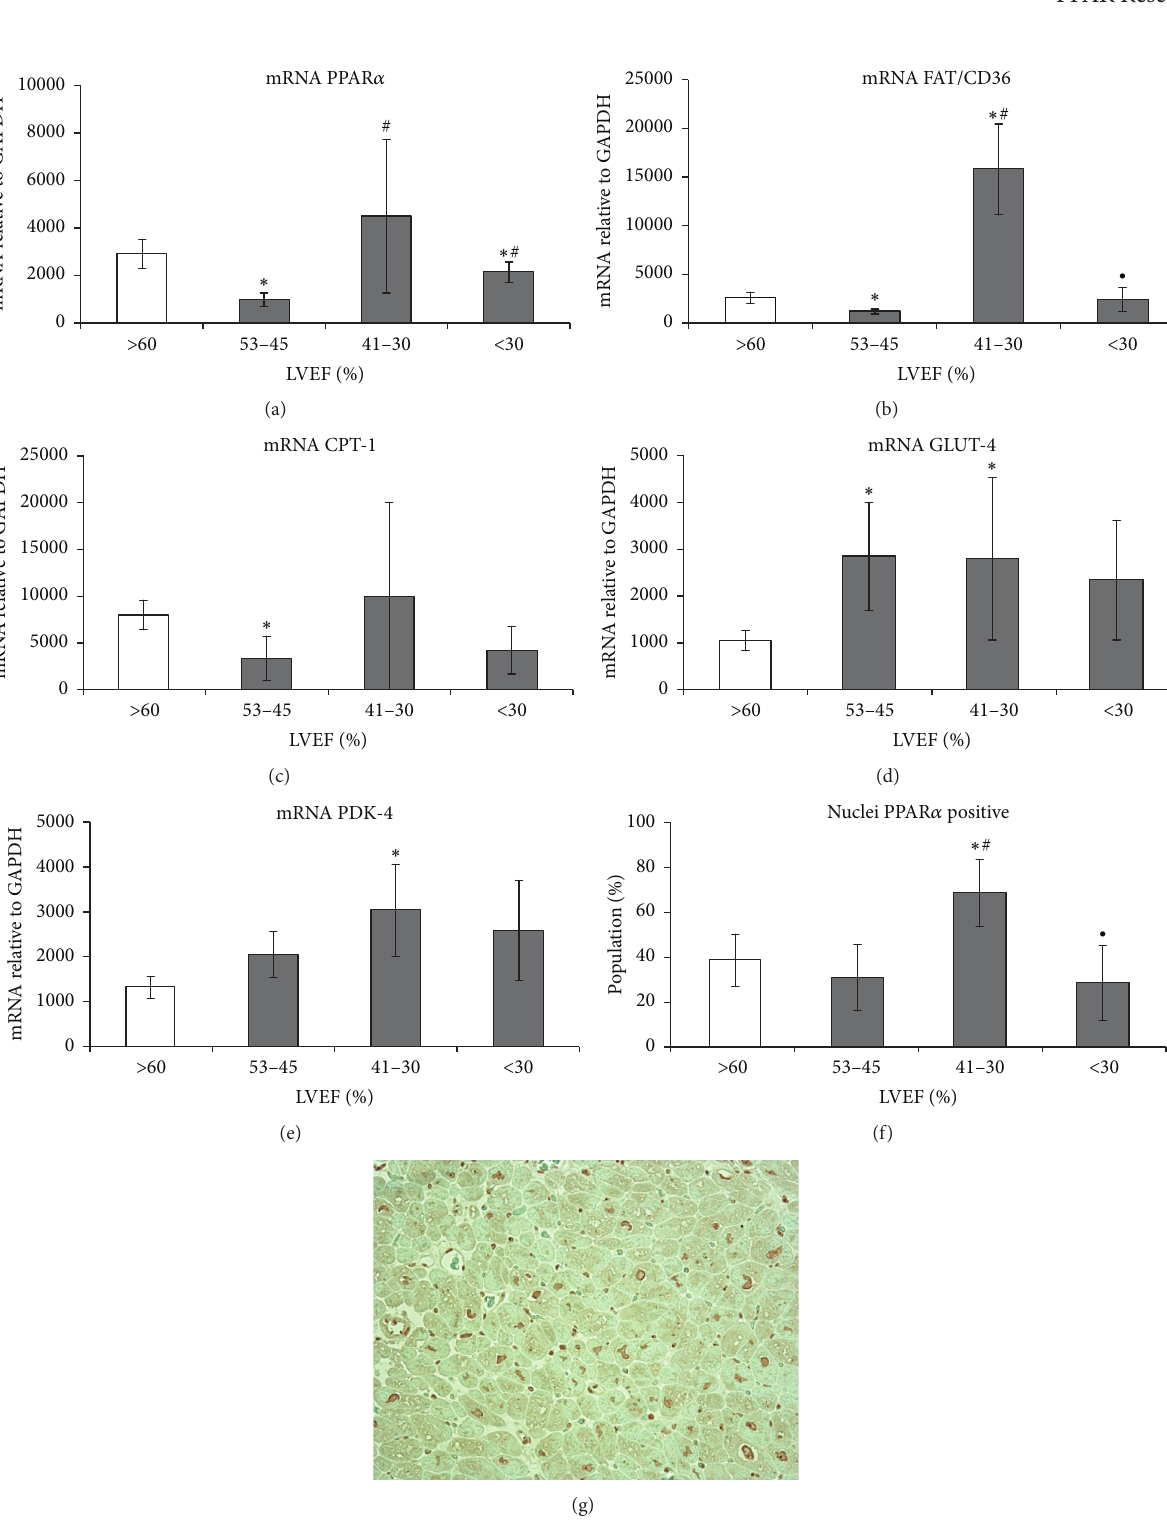
Figure 1: Changes in PPAR 𝛼 activity and in the related genes involved in fatty acid and glucose metabolism in the myocardium of the human heart during heart failure progression. Myocardial expression of (a) PPAR 𝛼 mRNA; (b) FAT/CD36 mRNA; (c) CPT-1 mRNA; (d) GLUT- 4 mRNA; (e) PDK-4 mRNA. GPDH was used as a housekeeping gene. Results are presented as mean ± SEM; ∗ 𝑝 < 0.05 versus control; # 𝑝 < 0.05 versus Group (I); PPAR 𝛼 expression in myocardial tissue section. (f) Morphometric analysis of cardiomyocyte population with PPAR 𝛼 -positive nuclei; results are presented as mean ± SEM; ∗ 𝑝 < 0.05 versus control; # 𝑝 < 0.05 versus Group (I); ∙ 𝑝 < 0.05 versus Group (II). (g) A representative image showing the expression of PPAR in the myocardial tissue section of the heart patient from Group